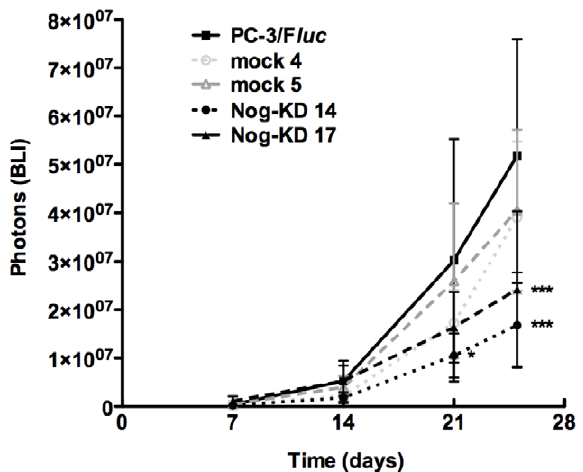
Figure 6. Noggin silencing limits growth of PC-3/F luc cells in bone xenografts. Bioluminescent signal (photons + / 2 SD) emitted from the cancer cell-xenografted tibiae was quantified at day 7, 14, 21 and 25 after intra-osseous inoculation of tumor cells; n =6–7 animals for each experimental group. *** P , 0.001, Nog-KD clones versus PC-3/F luc at day 25; * P , 0.05, Nog-KD 14 versus PC-3/F luc at day 21.